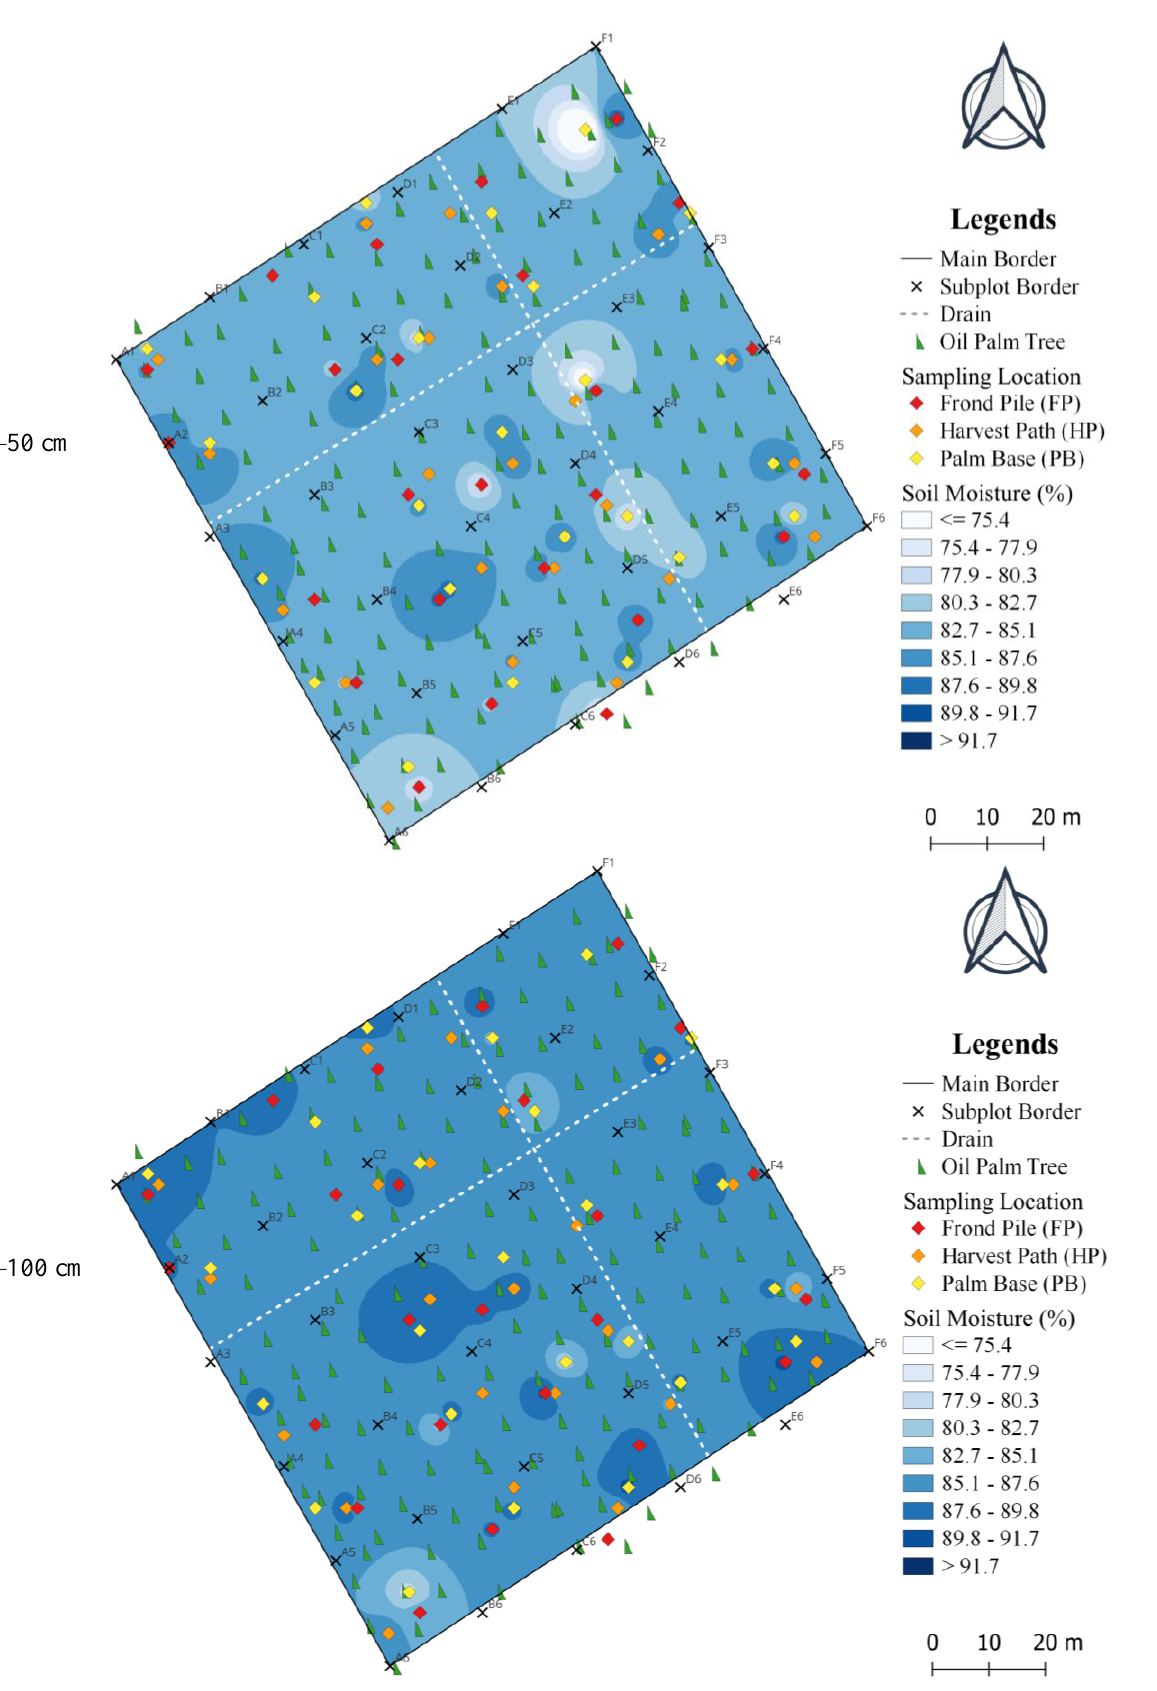
Figure 3. Maps showing the spatial distributions of subplots, sampling points, trees, drains and moisture content in shallow (0–50 cm and 50–100 cm) soil layers at Sebungan Estate oil palm